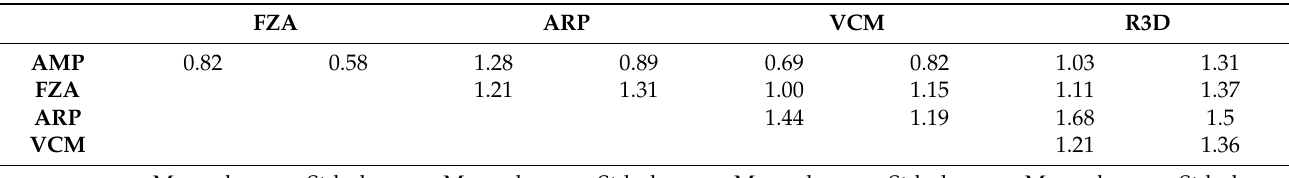
Table 13. Hausdorff distances between the photogrammetric models for the stone bust case study—dataset 6 (distances in mm).